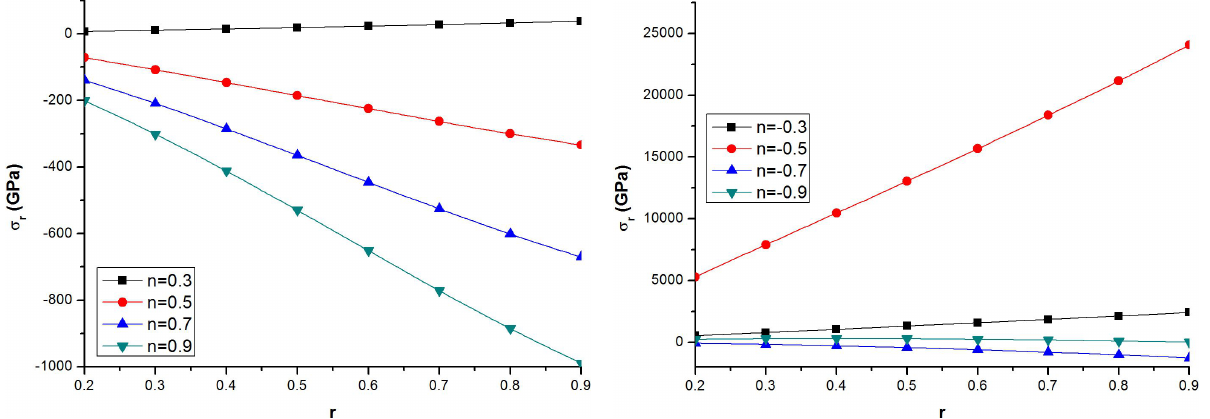
Figure 8: Radial stress versus radial coordinate for various values of n under steady state temperate